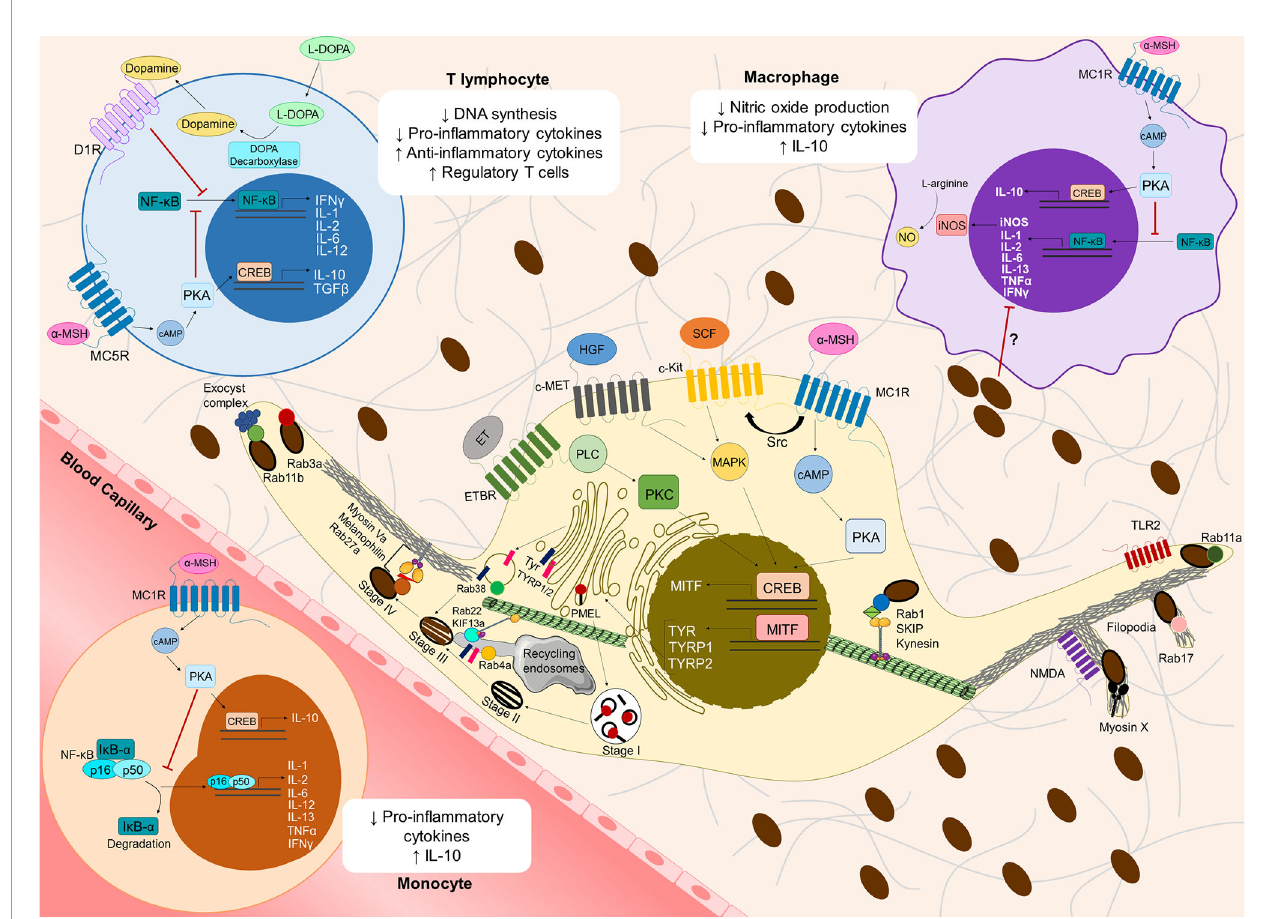
FIGURE 1 | Overview of cutaneous melanoma-related molecular mechanisms involved in melanin synthesis, transport and secretion, and their contribution to an immunosuppressive microenvironment. Several receptors at the plasma membrane [Melanocortin 1 receptor (MC1R), c-Kit receptor tyrosine kinase (c-Kit), c-Met receptor tyrosine kinase (c-Met) and Endothelin receptor type B (ETBR)] recognize distinct keratinocyte/ fi broblast-derived soluble factors [ a -Melanocyte stimulating hormone ( a -MSH), Stem-cell factor (SCF), Hepatocyte growth factor (HGF) and Endothelin (ET)], inducing several signaling pathways, which in turn activate the cAMP response element-binding protein (CREB) and subsequently the Microphthalmia-associated transcription factor (MITF). MC1R can transactivate c-Kit receptor by recruiting the tyrosine kinase Src. MITF stimulates the synthesis of the melanogenic enzymes Tyrosinase (Tyr) and Tyrosinase-related protein 1/2 (TYRP1/2), which are transported from the Golgi to melanosomes to initiate melanogenesis. Melanin production requires melanosome maturation, a process that can be divided in four different stages (I to IV). Stage I melanosomes are early endosome-derived organelles containing intraluminal vesicles, which serve as platforms for the deposition of the glycoprotein PMEL. PMEL is later cleaved to form the internal fi brillar striations of stage II melanosomes, giving them an elliptical shape. Then, Tyr and TYRP1/2 are delivered to stage II melanosomes in Golgi-derived Rab38-positive vesicles. Moreover, Tyr and TYRP1/2 can also be delivered from recycling endosomes in a Rab4a-dependent manner and/or through tubular extensions dependent on the complex Rab22/KIF13a. In stage III melanosomes, melanin starts to deposit onto PMEL fi brils and melanosomes reach full maturation in stage IV. Melanosomes interact with the cytoskeleton via two tripartite complexes: Rab1/SKIP/Kinesin on microtubules and Rab27a/Melanophilin/MyosinVa on the cortical actin network at the melanocyte periphery. For melanosome secretion, Rab11b interacts with the exocyst tethering complex, while Rab11a is involved in melanin secretion mediated by Toll-like receptor 2 (TLR2). Moreover, Rab3a regulates melanin exocytosis induced by keratinocyte-conditioned medium. Myosin X, Rab17 and N-methyl-D-aspartate (NMDA) receptor are involved in melanin release through fi lopodia. The molecular regulators described above participate in cutaneous melanoma (CM) proliferation, migration, invasion and/or metastasis (see Supplementary Table 1 ). Melanogenesis intermediates also suppress the immune microenvironment, namely by modulating cytokine expression in monocytes, macrophages and T lymphocytes. The binding of a -MSH to MC1R at the surface of circulating monocytes or local macrophages, as well as its recognition by MC5R at the surface of T lymphocytes activates Protein kinase A (PKA) though cAMP, which in turn inhibits Nuclear factor kappa B (NF- k B) translocation to the nucleus. Consequently, the translation of several pro-in fl ammatory cytokines is inhibited. Furthermore, a -MSH induces the production of anti-in fl ammatory cytokines (IL-10, TGF b ), possibly through CREB activation, thereby increasing the in fi ltration of regulatory T cells in the CM microenvironment. In macrophages, inhibition of NF- k B by a -MSH also decreases the levels of nitric oxide synthase (iNOS), which in turn inhibits nitric oxide production. L-DOPA has been shown to decrease DNA synthesis and pro- in fl ammatory cytokine production in T lymphocytes, but molecular mechanisms behind it remain mostly unknown. Interestingly, T lymphocytes can express DOPA decarboxylase, which converts L-DOPA into dopamine. Through autocrine signaling, dopamine can bind to dopamine receptors at the surface of T lymphocytes ( e.g. D1R) and suppress these cells. Melanin itself might also suppress pro-in fl ammatory cytokine production in monocytes/macrophages, but the molecular mechanisms underlying this process remain